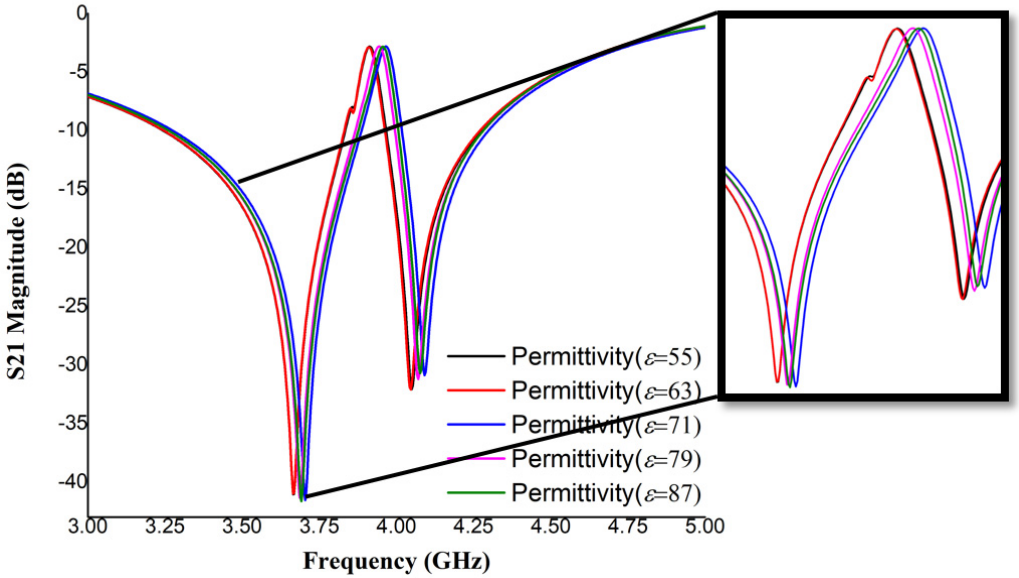
Figure 6. Transmission coefficient performance (simulation) regarding the sensing varying layer dielectric constant (with the shifting portion in the enlarged view).